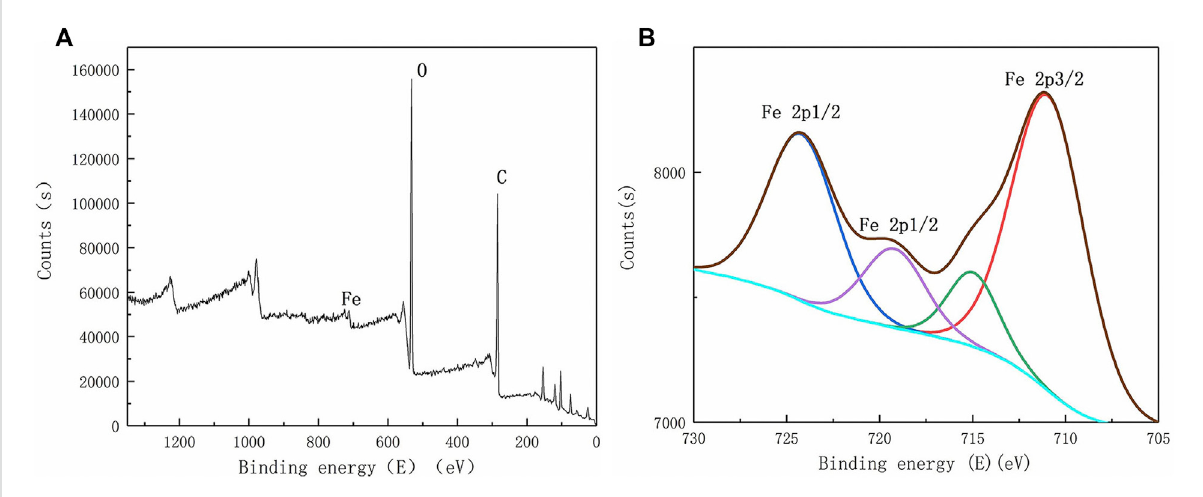
FIGURE 9 X-ray photoelectron spectroscopy after phosphorus adsorption (A) complete spectrum; (B) enlarged spectrum of Fe.